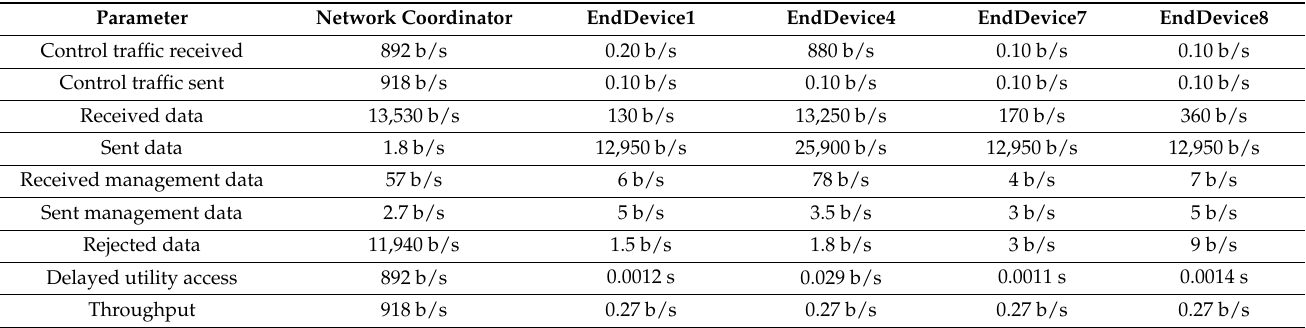
Table 2. Device statistics—baseline parameters—scenario